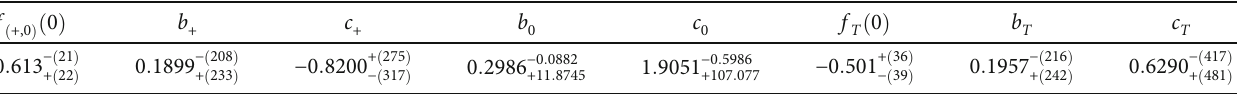
, c Þ in Eq. (52) for the D ⟶ π TFFs with m j j